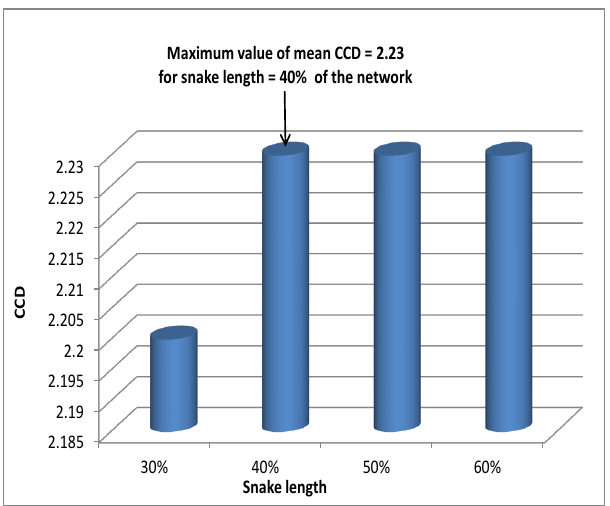
Figure 8. The mean values of connected clusters’ dissimilarity versus snake length computed as a percentage of the size of the network of roads.